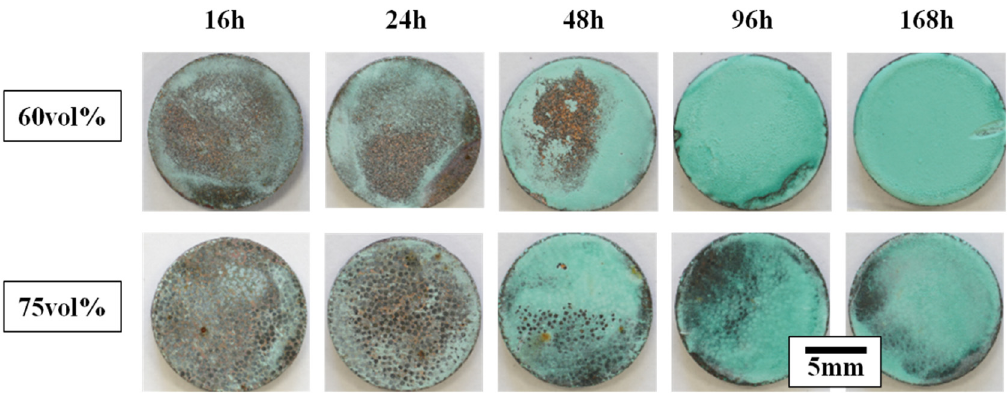
Figure 1. Photographs of the Diamond/Cu composites corroded surfaces after salt spray testing for different times.